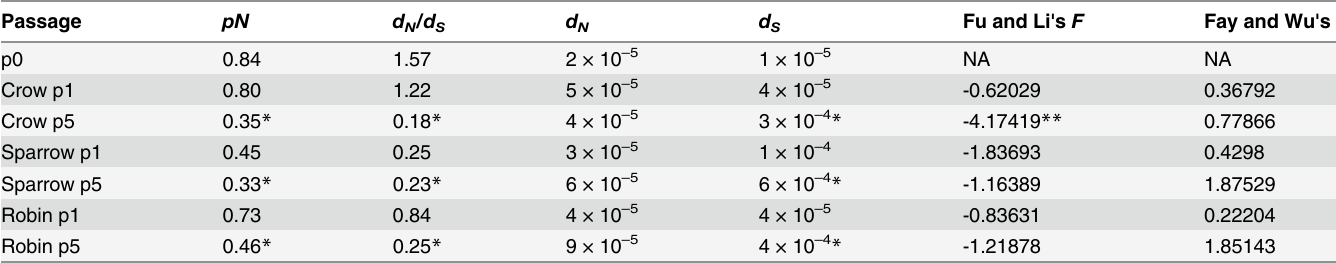
Table 1. Intrahost tests of